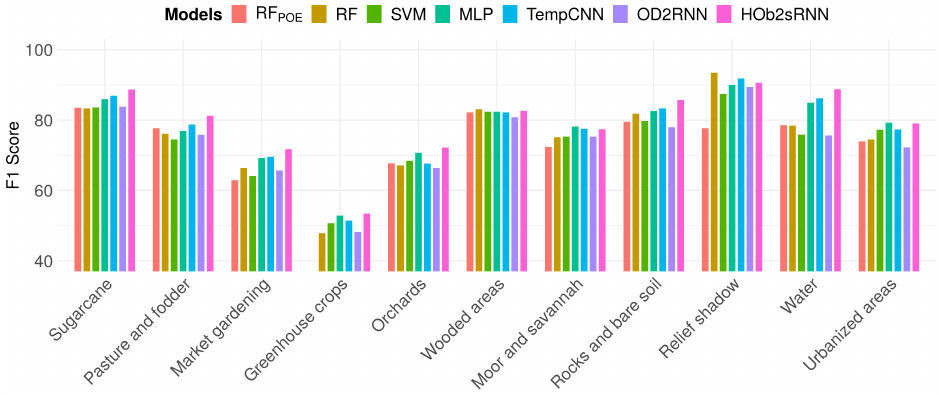
Figure 9. Per-Class F1 score for the Reunion island (average over ten random splits).